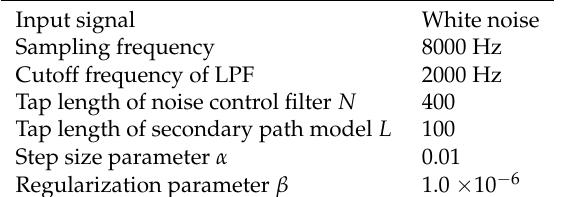
Table 3. Experimental conditions of noise reduction experiment 1.